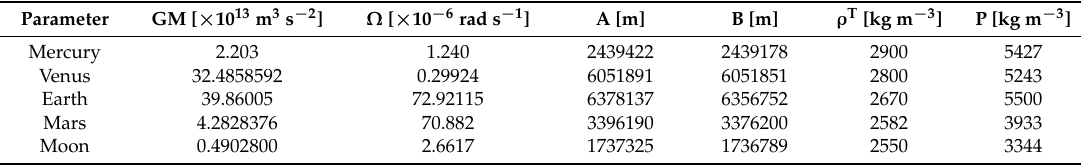
Table 1. Adopted parameters: GM, a, b and ω for Mercury, Venus, Earth, Mars and the Moon.